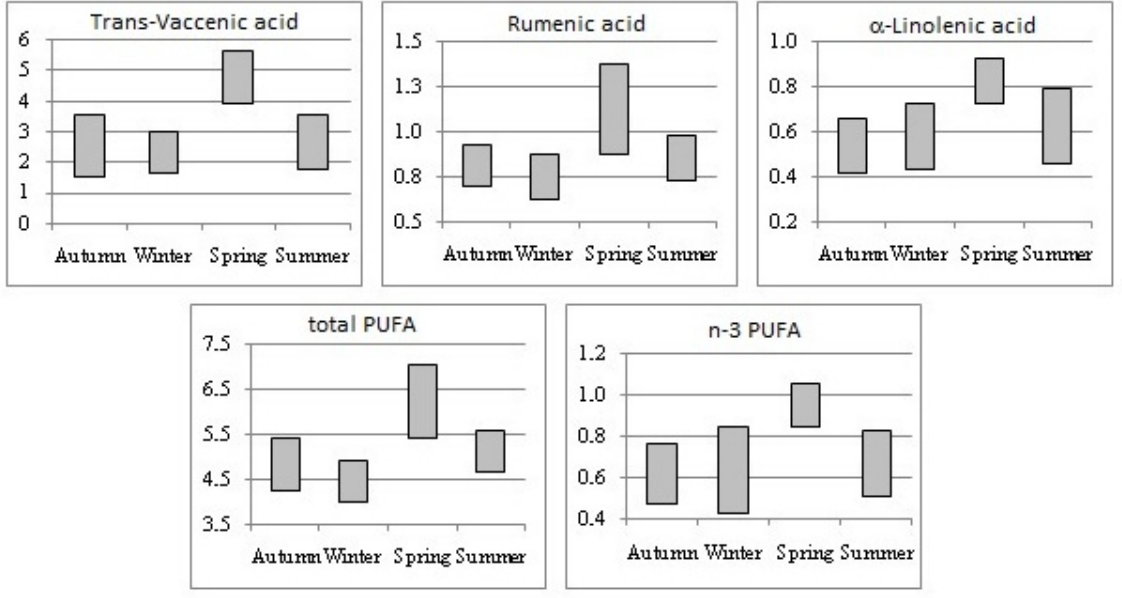
Figure 1. Seasonal variation (minimum value–maximum value) in fatty acids (g/100 g FA) in cheeses.